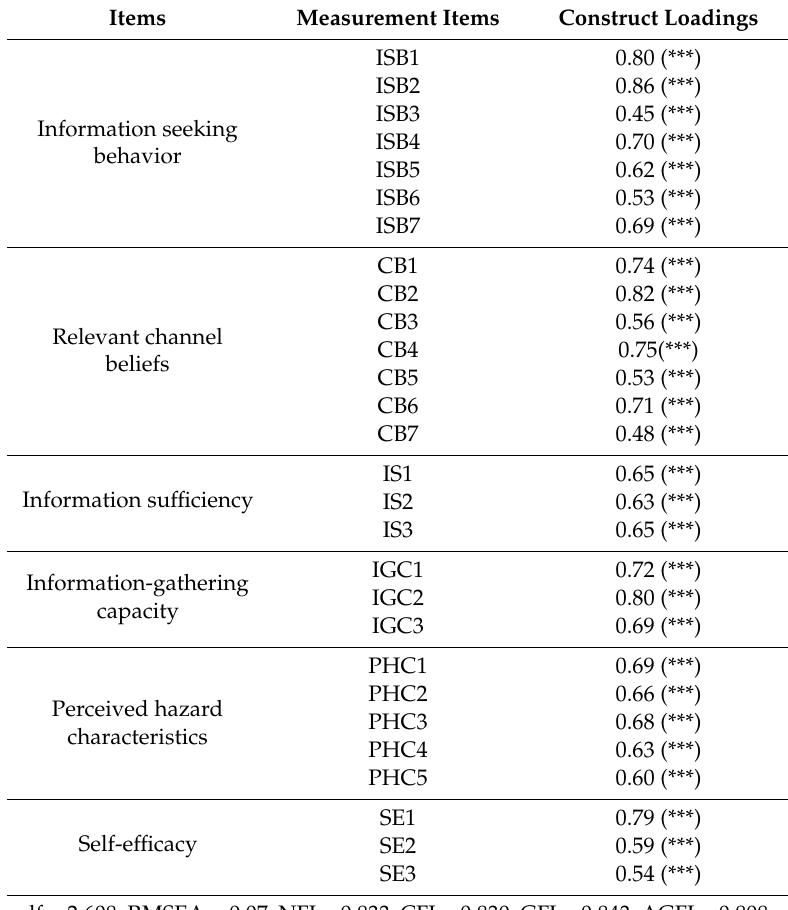
Table 3. Overall confirmatory factor analysis for the measurement